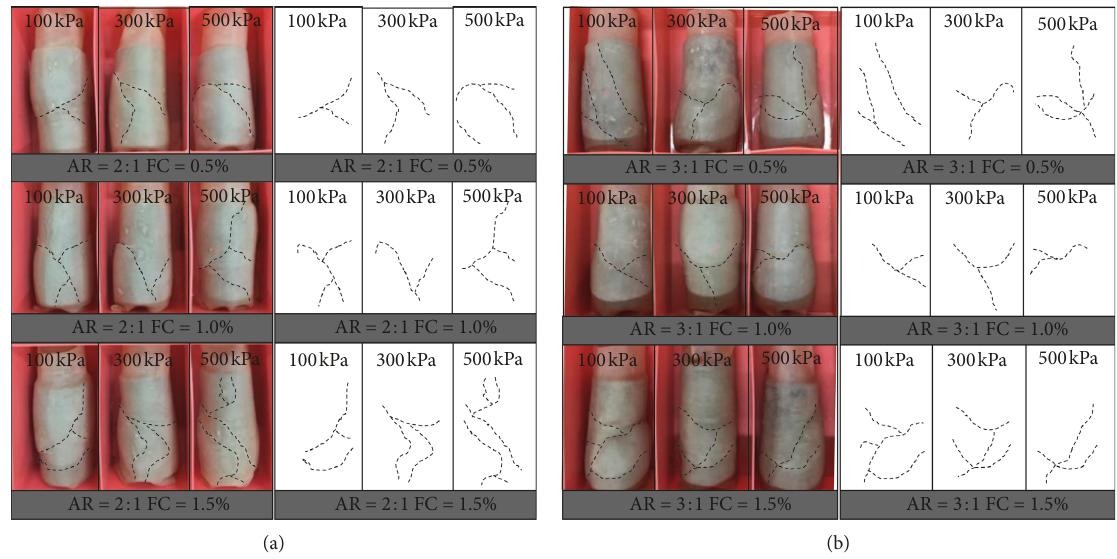
Figure 12: Macroscopic morphology of cement-stabilized sand reinforced with waste polyester fiber fabric blocks: (a) aspect ratio of 2:1; (b) aspect ratio of